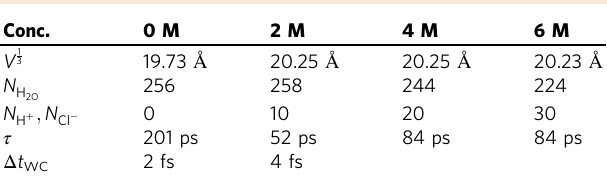
Table 2 Parameters of the ab initio molecular dynamics